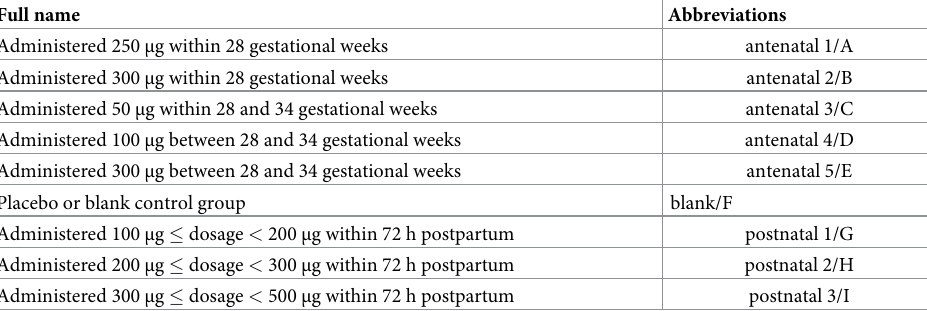
P > 0.05 indicates that no statistical inconsistencies were observed, suggesting that a network meta-analysis can be accomplished by directly or indirectly comparing different therapeutic measures. Thus, data on various treatment measures can be converged using consistency models. Results of the Bayesian network meta-analysis. According to the network of comparisons (Table 4), the antenatal 5/E, antenatal 2/B, antenatal 4/D, antenatal 1/A, postnatal 3/I, postnatal 2/H, and antenatal 3/C regimens significantly reduced the serum anti-D antibody-positive rates compared with that of the blank/F regimen alone (antenatal 5/E vs. blank/F: OR = 0.00, 95% CI = 0.00–0.04; antenatal 2/B vs. blank/F: OR = 0.01, 95% CI = 0.00–0.01; antenatal 4/D Table 2. Treatment